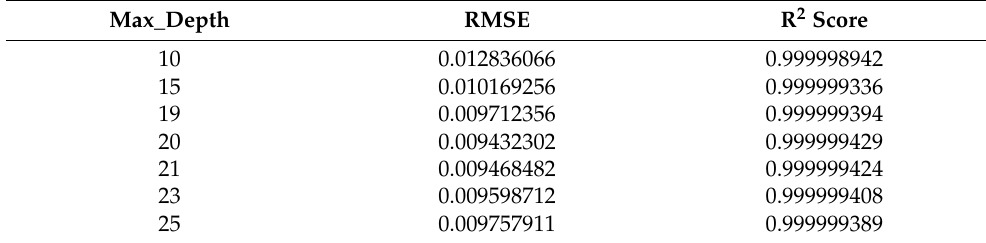
Table 2. max_depth adjustment corresponding error and score.